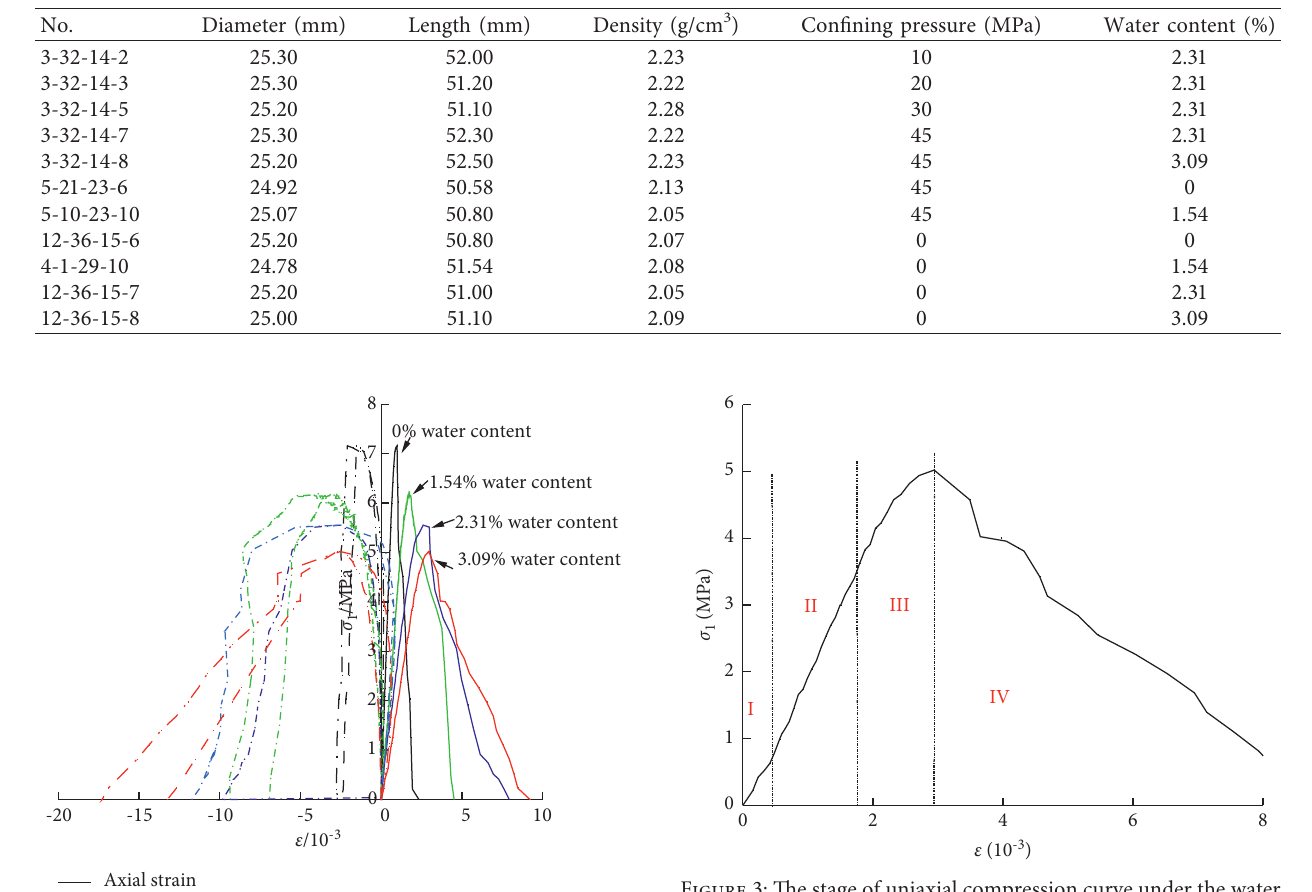
Figure 1: Rock mechanics experimental system of Table 1: The specimen basic information and testing procedure.